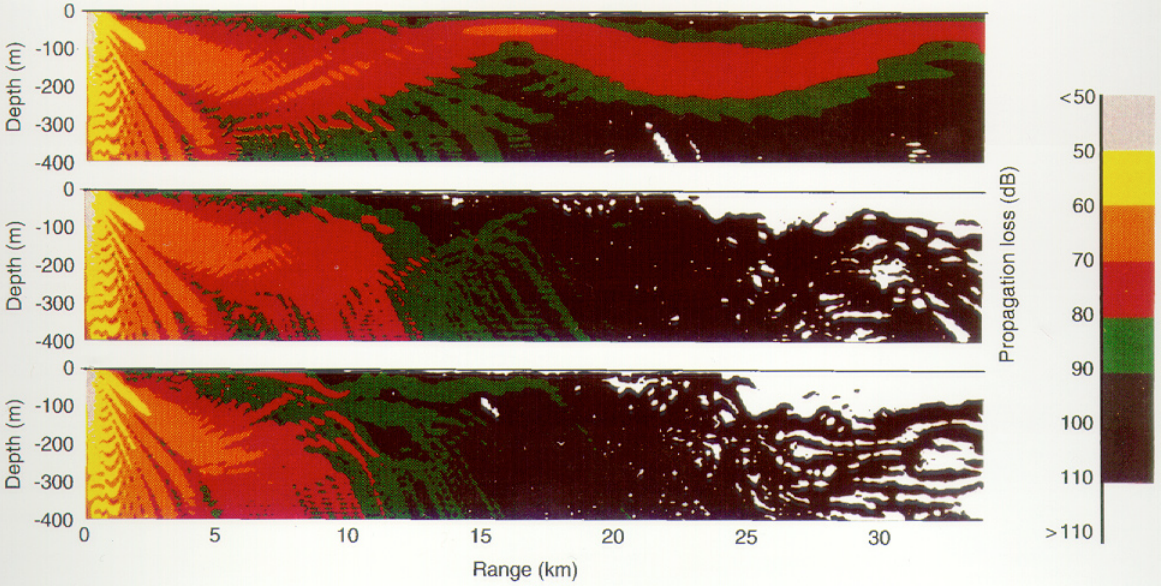
Fig. 12. Propagation-loss contours through the frontal environment, frequency 400 Hz, source depth 50 m. „ op panel range-independent background, middle panel feature model, bottom panel observed